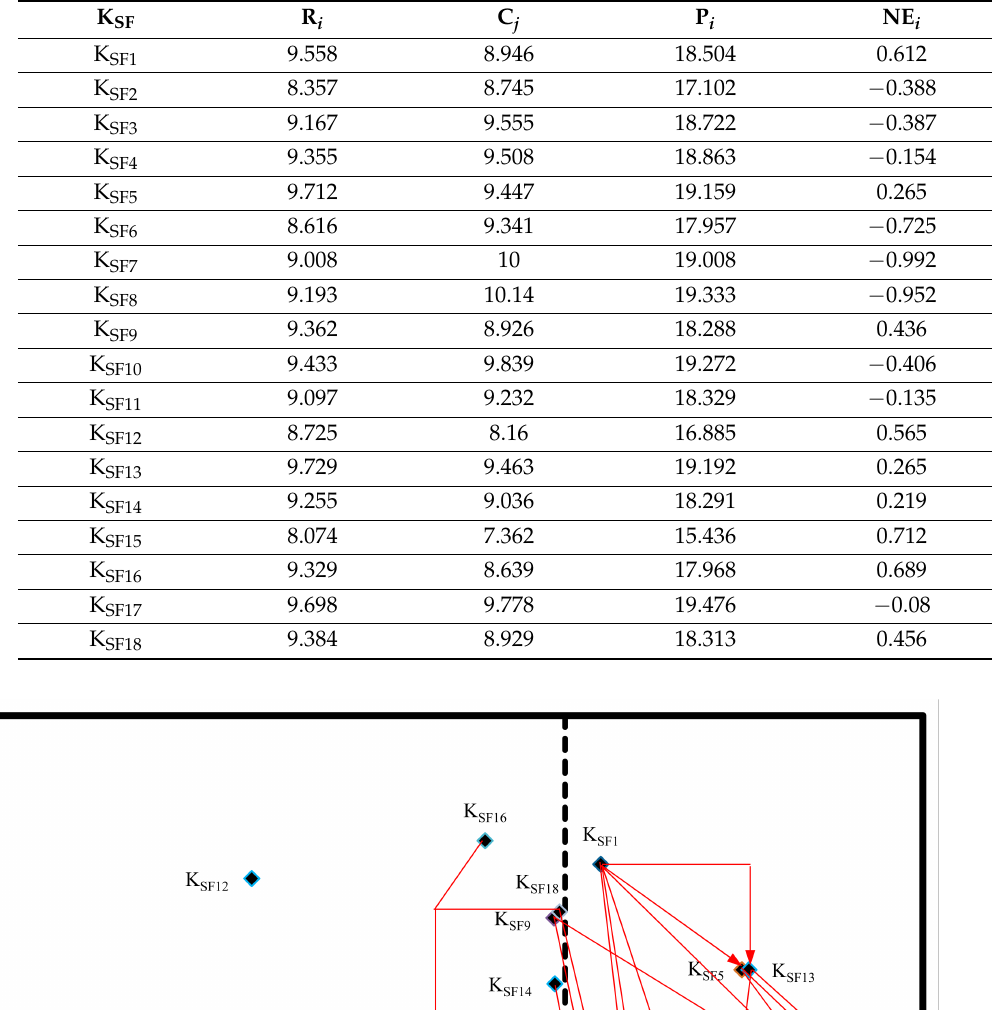
Table 4. Prominence and net effect of the KSFs of BIM implementation.